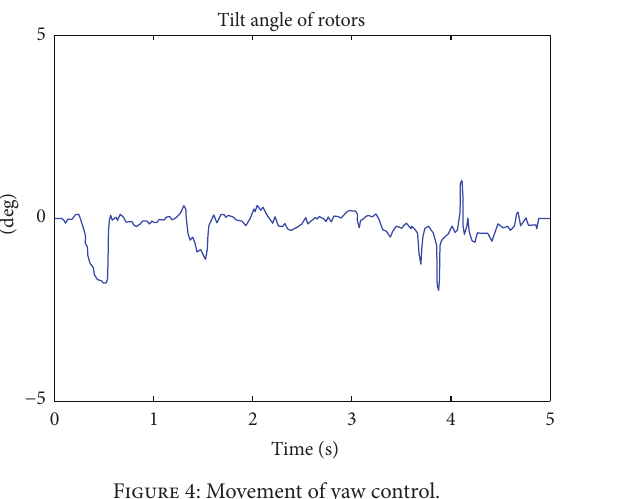
Figure 4: Movement of yaw control.